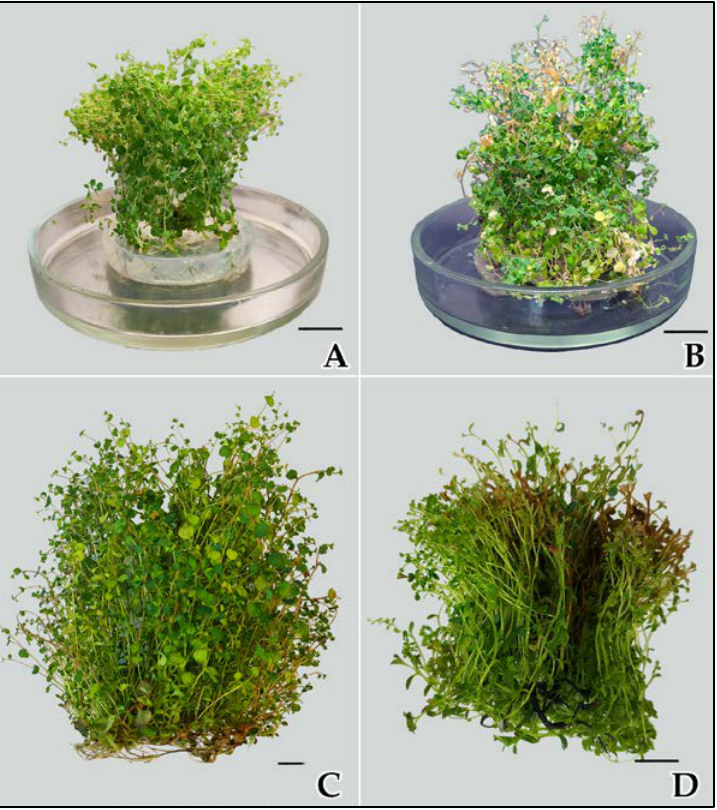
Figure 2. Microshoots of S. betulifolia ssp. aemiliana after ( A ) 60 days, ( B ) and 90 days of culturing in the agar-solidified medium, and after ( C ) 60 days, ( D ) and 90 days of culturing in the liquid medium. Scale bar: 1 cm.